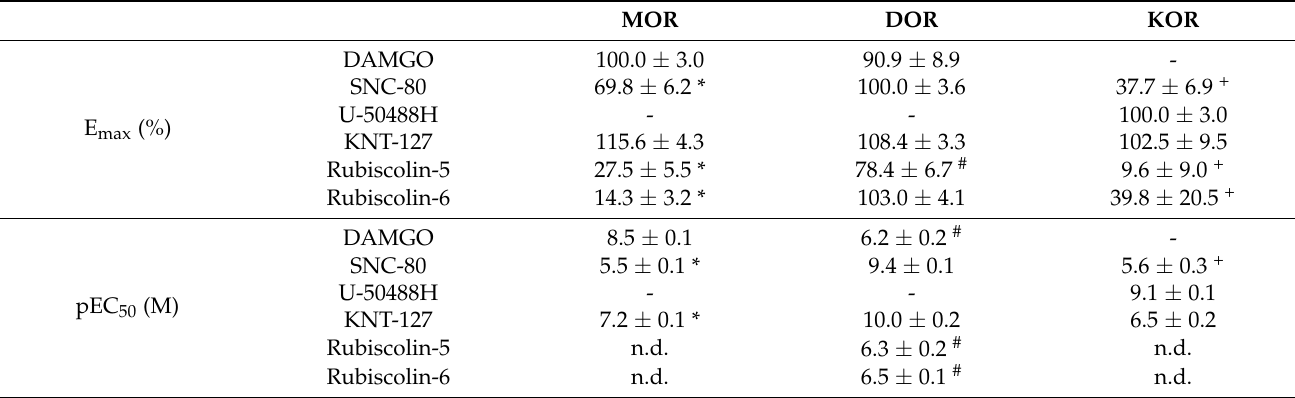
Table 1. E max and pEC 50 values for rubiscolins and opioid compounds obtained in the cAMP assay for MOR, DOR, and KOR.